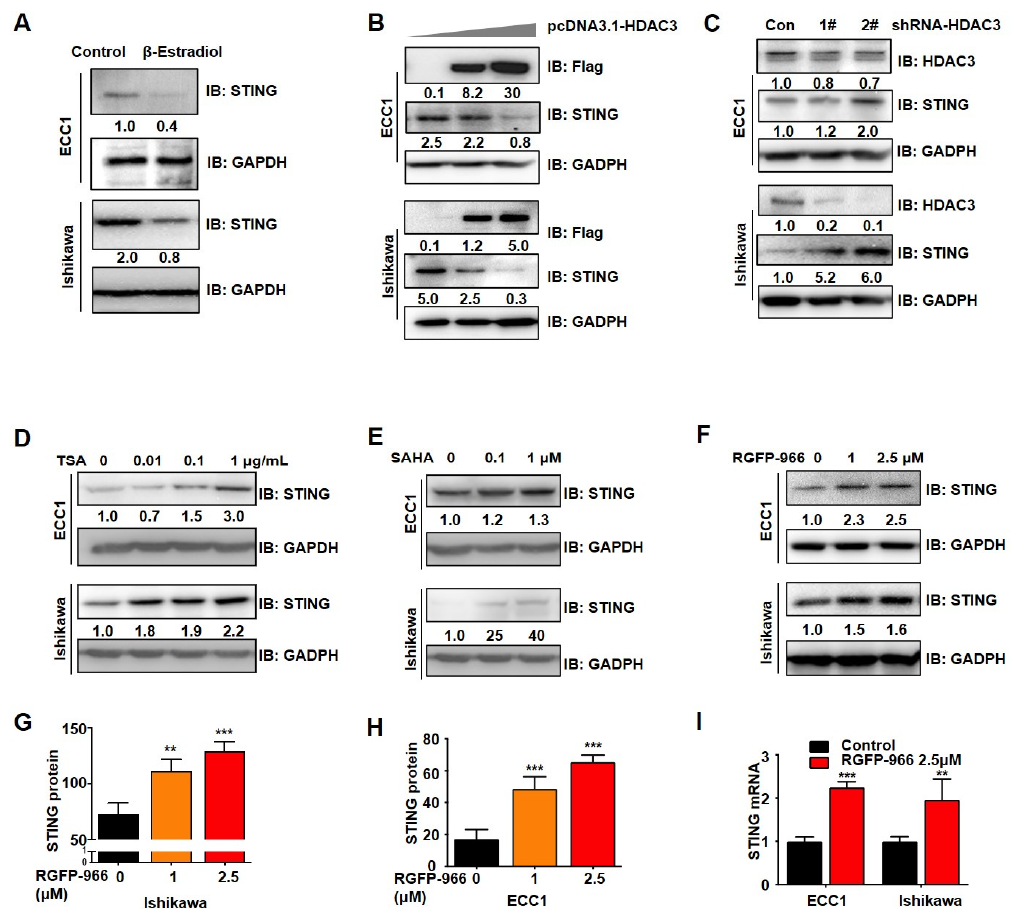
Figure 4. Both β -estradiol and HDAC3 inhibit STING expression. ( A ) IB analysis of WCL derived from HEC1A cells treated with 0–100 nM β -estradiol for 24 h. ( A ) IB analysis of WCL derived from ECC1 cells and Ishikawa cells treated with 10 nM β -estradiol for 24 h. ( B , C ) IB analysis of WCL derived from ECC1 and Ishikawa cells. Cells were transfected with pcDNA3.1-HDAC3 ( B ) constructs or shRNA-HDAC3 ( C ) for 24 h. ( D , E ) ECC1 and Ishikawa cells were treated with TSA (0, 0.01, 0.1, and 1 μ g/mL) for 24 h ( D ), with increasing doses of SAHA (0, 0.1, and 1 μ M) for 24 h ( E ), and with increasing doses of RGFP-966 for 24 h ( F ). ( G , H ) Protein quantification of STING using Image J software. ( I ) qPCR analysis of ECC1 and Ishikawa cells treated with 2.5 μ M RGFP-966 for 24 h. The cell-based experiments were repeated at least three times, and representative results are shown as mean ± SD. t -test analyses were used to calculate the p -value. ** p < 0.001, *** p < 0.0005 significantly different from control. Original image of Western blot can be found in File S1.